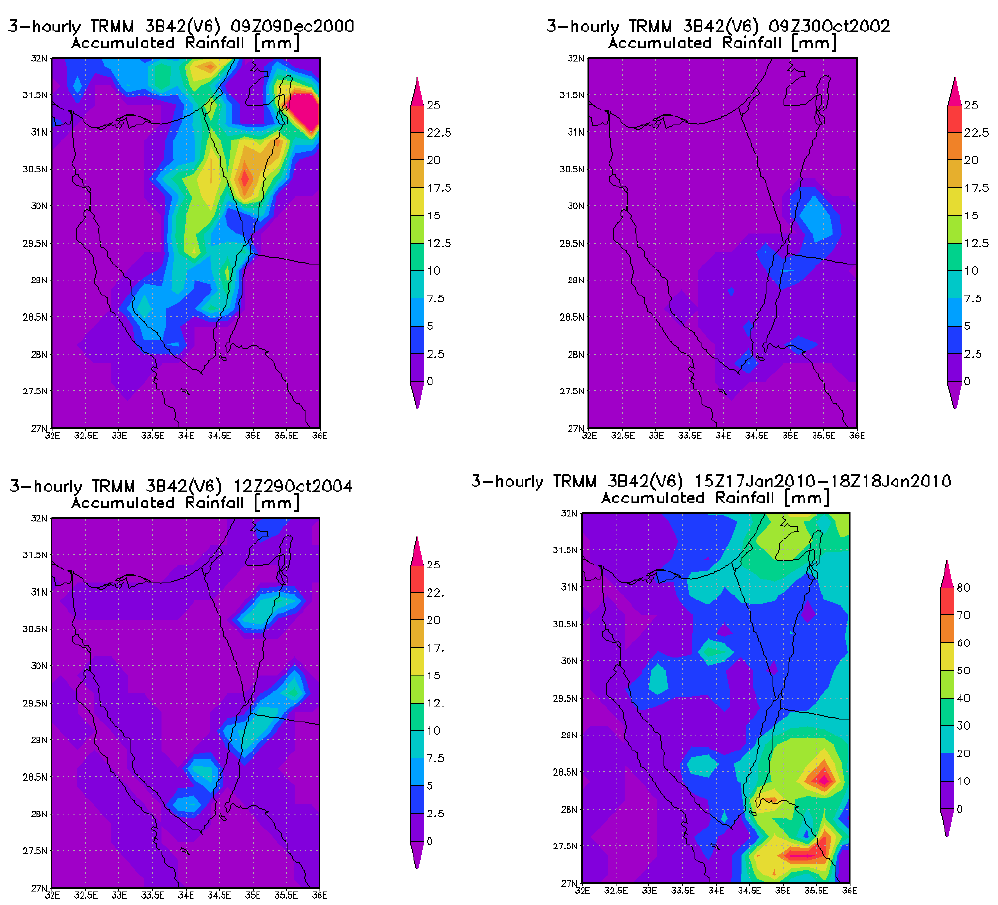
Fig. 7. Selection of 3-hourly rainfall estimates from TRMM for the events in December 2000, October 2002, October 2004, and January 2010. Images have been extracted with NASA’s Giovanni